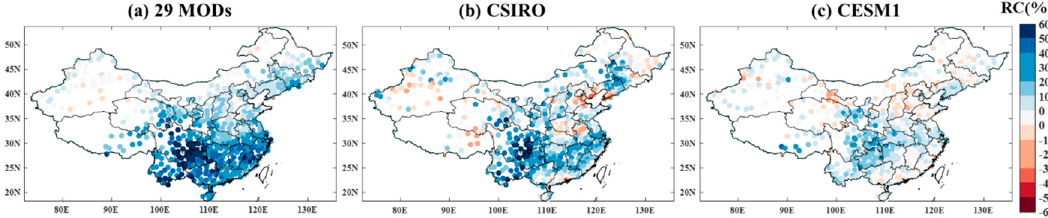
Figure 11. Spatial patterns of changes of 30-year return periods of drought severity in the near future relative to the reference period over 659 stations in China ( a ) 29 climate models; ( b ) 10-member CSIRO; ( c ) 40-member CESM1.